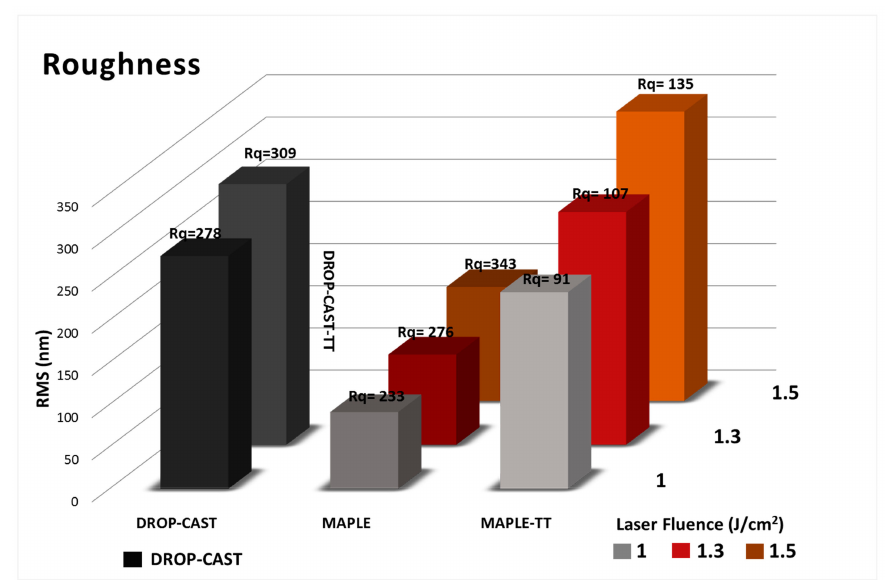
Figure 4. The roughness of the PVDF bulk: drop-cast and drop-cast TT, with thin films obtained by MAPLE deposition and subsequently thermally treated with di ff erent laser fluences of 1.0 J / cm 2 , 1.3 J / cm 2 , and 1.5 J / cm 2 (from the AFM measurements on areas of 20 × 20 µ m 2 like in Figure 3).